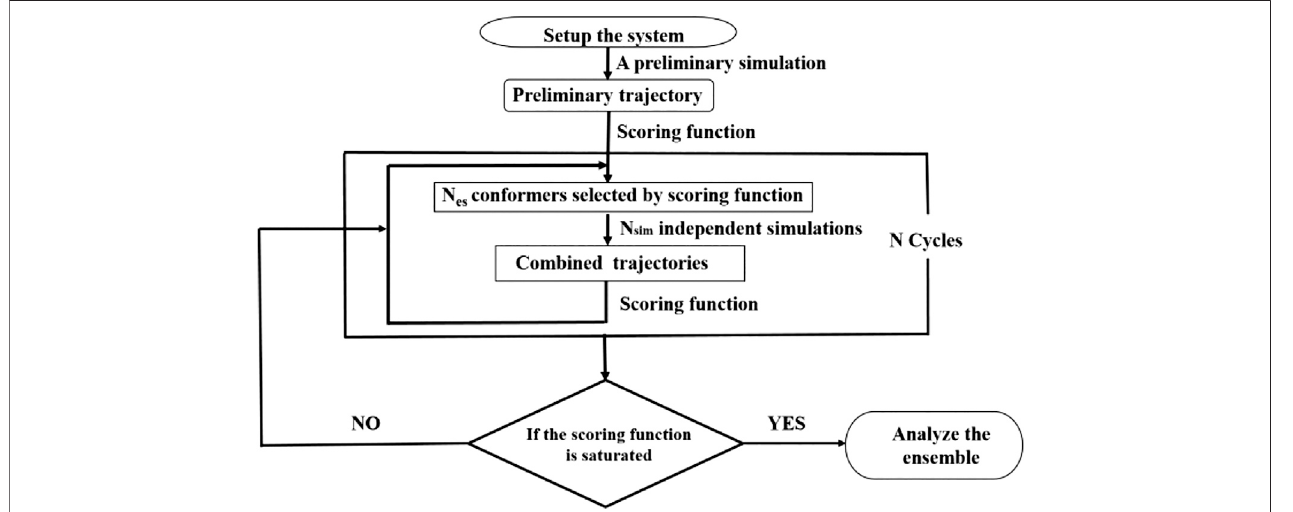
FIGURE 2 | Flowchart of integrative modeling that is a modi fi cation from Figure 1 in (Cheng et al.,